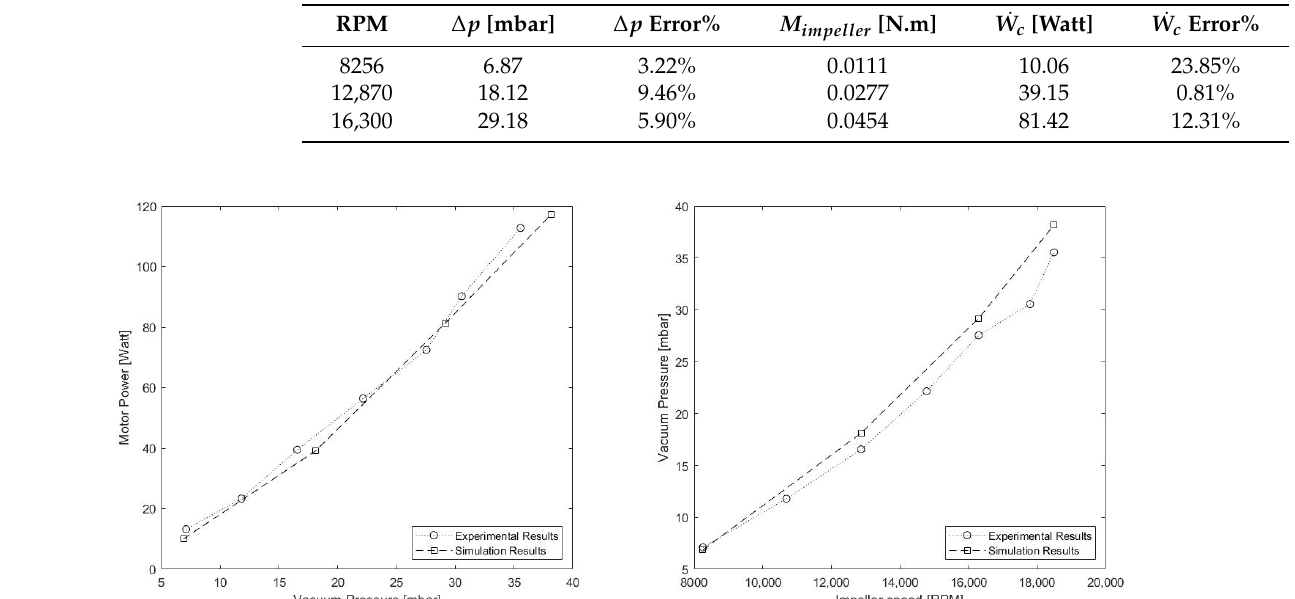
Figure 9. TBP simulation vs. experimental results graph: ( left ) vacuum pressure vs. motor power. ( right ) impeller speed vs. vacuum pressure.